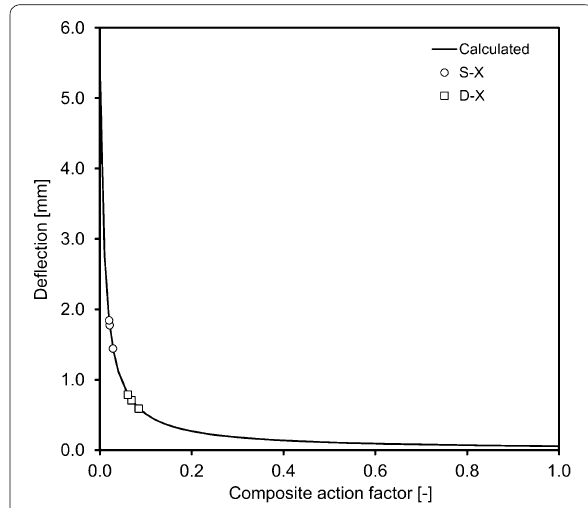
Fig. 10 Calculated elastic deflection δ at the mid-span of the sandwich beam in four-point bending (P composite action factor α. The points corresponding to the beam test results are also indicated.